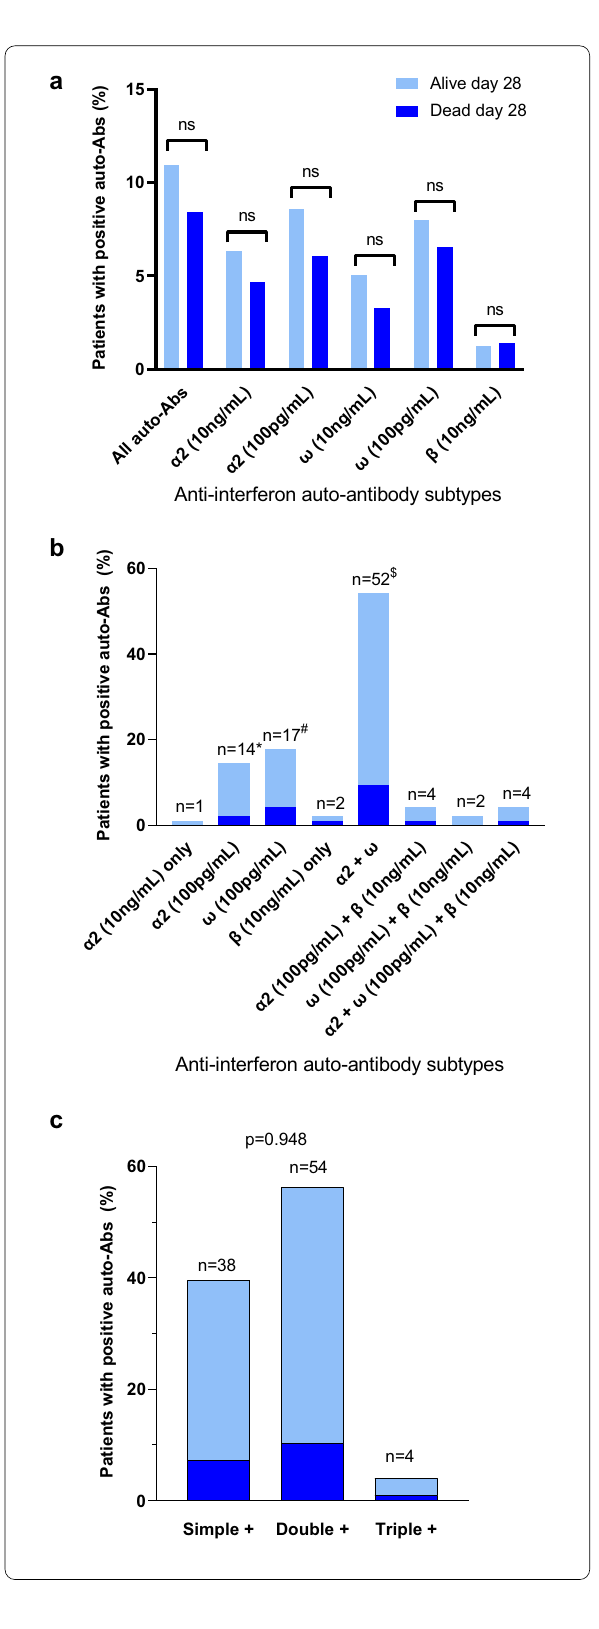
Fig. 2 Distribution of auto‑antibodies (auto‑Abs) to specific sets of type I interferons (IFNs) according to 28‑day mortality. a Proportion of specific sets of auto‑Abs (several patients have more than one auto‑Abs resulting in total number being greater than 96; b proportion of combinations of auto‑Abs to specific sets of type I IFNs (total numbers add‑up to 96); α 2: auto‑Abs anti‑IFN‑α2; ω : auto‑Abs anti‑IFN‑ω; β : auto‑Abs anti‑IFN‑β; *including 6 patients who also had anti‑IFN‑α2 (10 ng/mL) auto‑Abs; # including 2 patients who also had anti‑IFN‑ω (10 ng/mL) auto‑Abs; $ including 6 patients who had anti‑IFN‑α2 (100 pg/mL) and anti‑IFN‑ω (100 pg/mL), 4 patients with anti‑IFN‑α2 (100 pg/mL 10 ng/mL) and anti‑IFN‑ω (10 ng/mL), 35 + patients with anti‑IFN‑α2 (100 pg/mL 10 ng/mL) and anti‑IFN‑ω + (100 pg/mL 10 ng/mL), 6 patients with IFN‑α2 (100 pg/mL 10 ng/ + + mL) and anti‑IFN‑ω (100 pg/mL) and 1 patient with IFN‑α2 (10 ng/ mL) anti‑IFN‑ω (100 pg/mL 10 pg/mL) auto‑Abs; c distribution + + of patients with simple, double or triple positive auto‑Abs; P value comes from the Fisher exact test. Patients who were alive at 28‑day are shown in light blue and patients who were dead at 28‑day are shown in dark blue ( b , c ); NS: p ‑value >